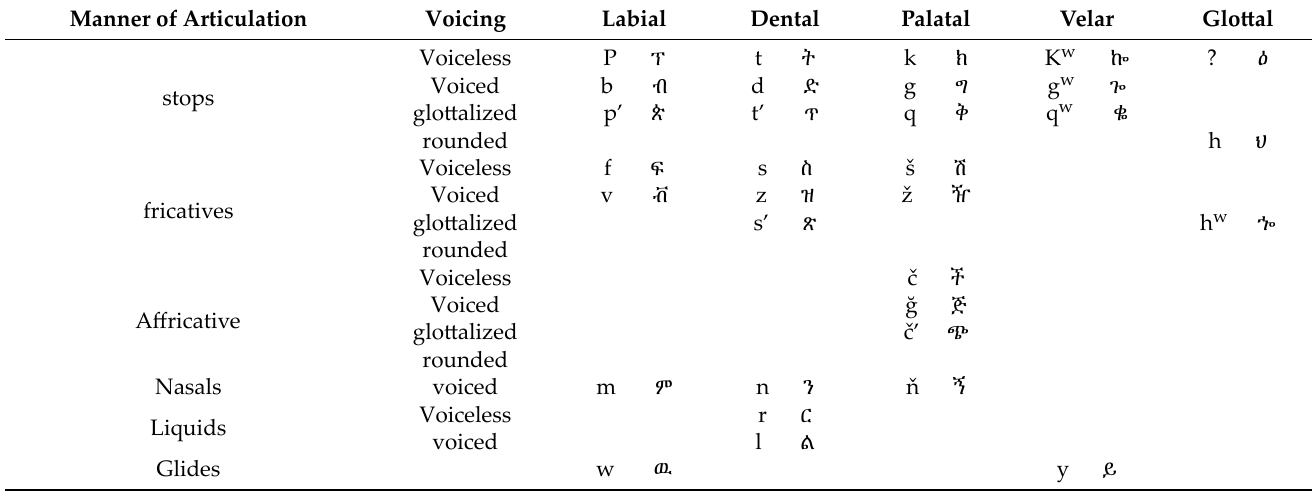
Table A2. Amharic consonants are arranged based on